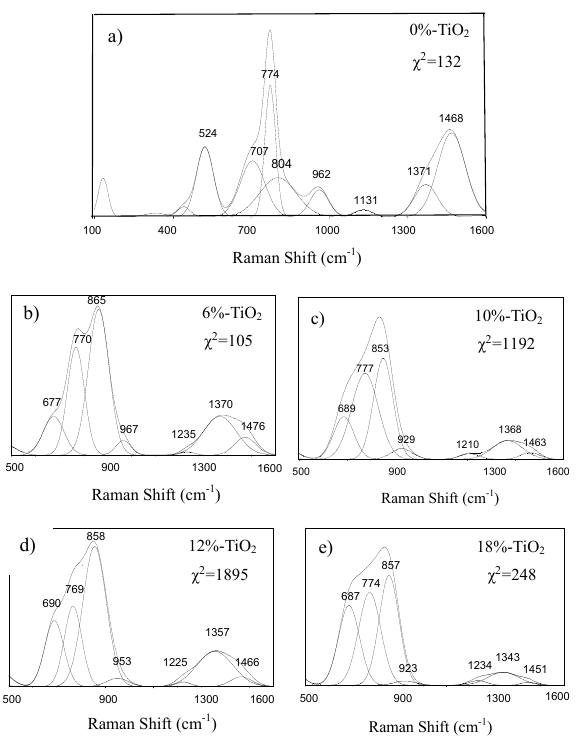
Figure 5. Deconvoluted results of Raman spectra for sam- ples with different TiO 2 contents.